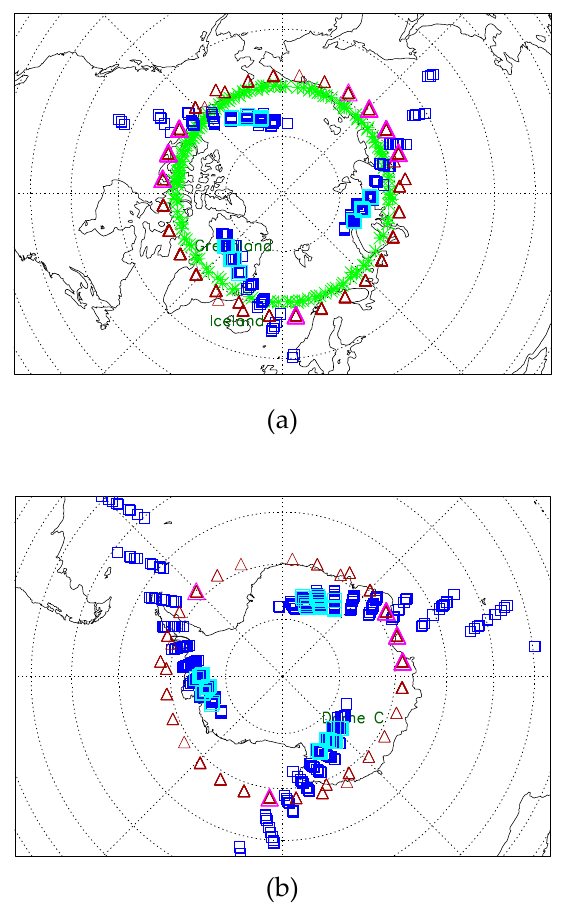
Figure 2. The precise SNOs of Sentinel-3A versus SNPP satellite (green stars) in 2017, Aqua versus SNPP satellite for the entire SNPP mission (blue squares) and in 2017 (cyan squares), and Terra versus SNPP satellite for the entire SNPP mission (red diamonds) and in 2017 (magenta diamonds), over ( a ) northern polar region and ( b ) southern polar region.